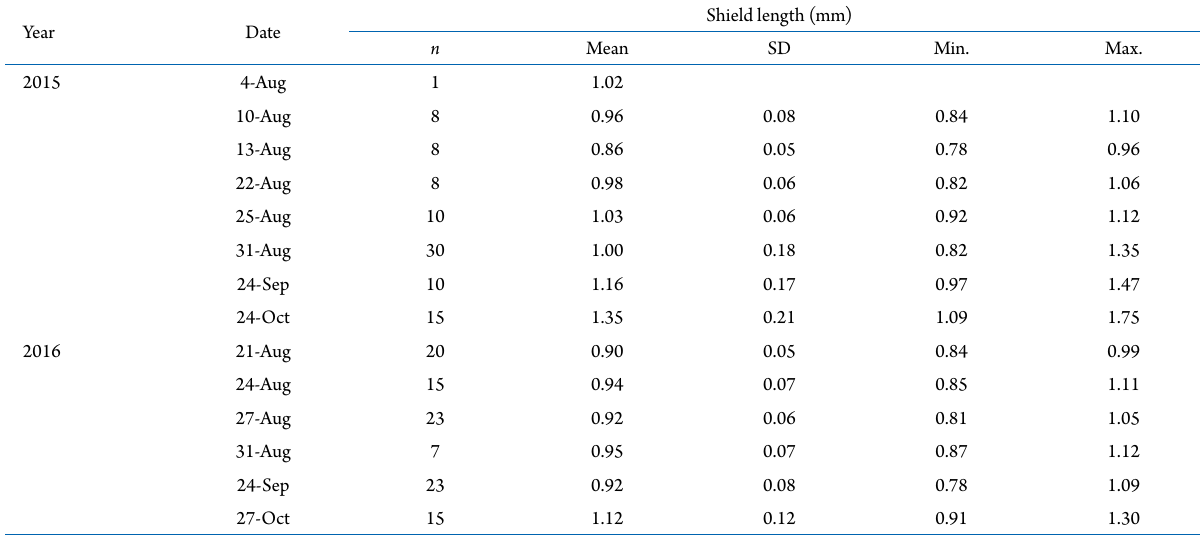
Table 1. Shield length of early juvenile land hermit crabs at the beach of Banda on the Boso Peninsula, Japan.